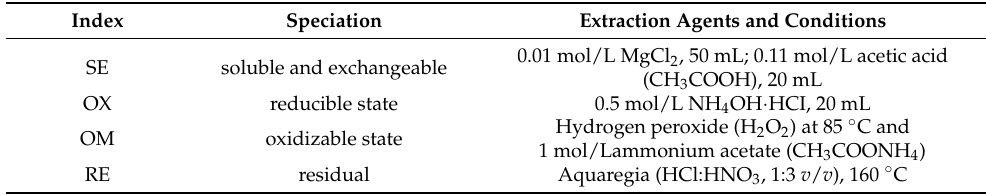
Table 1. Continuous extraction of metals in the